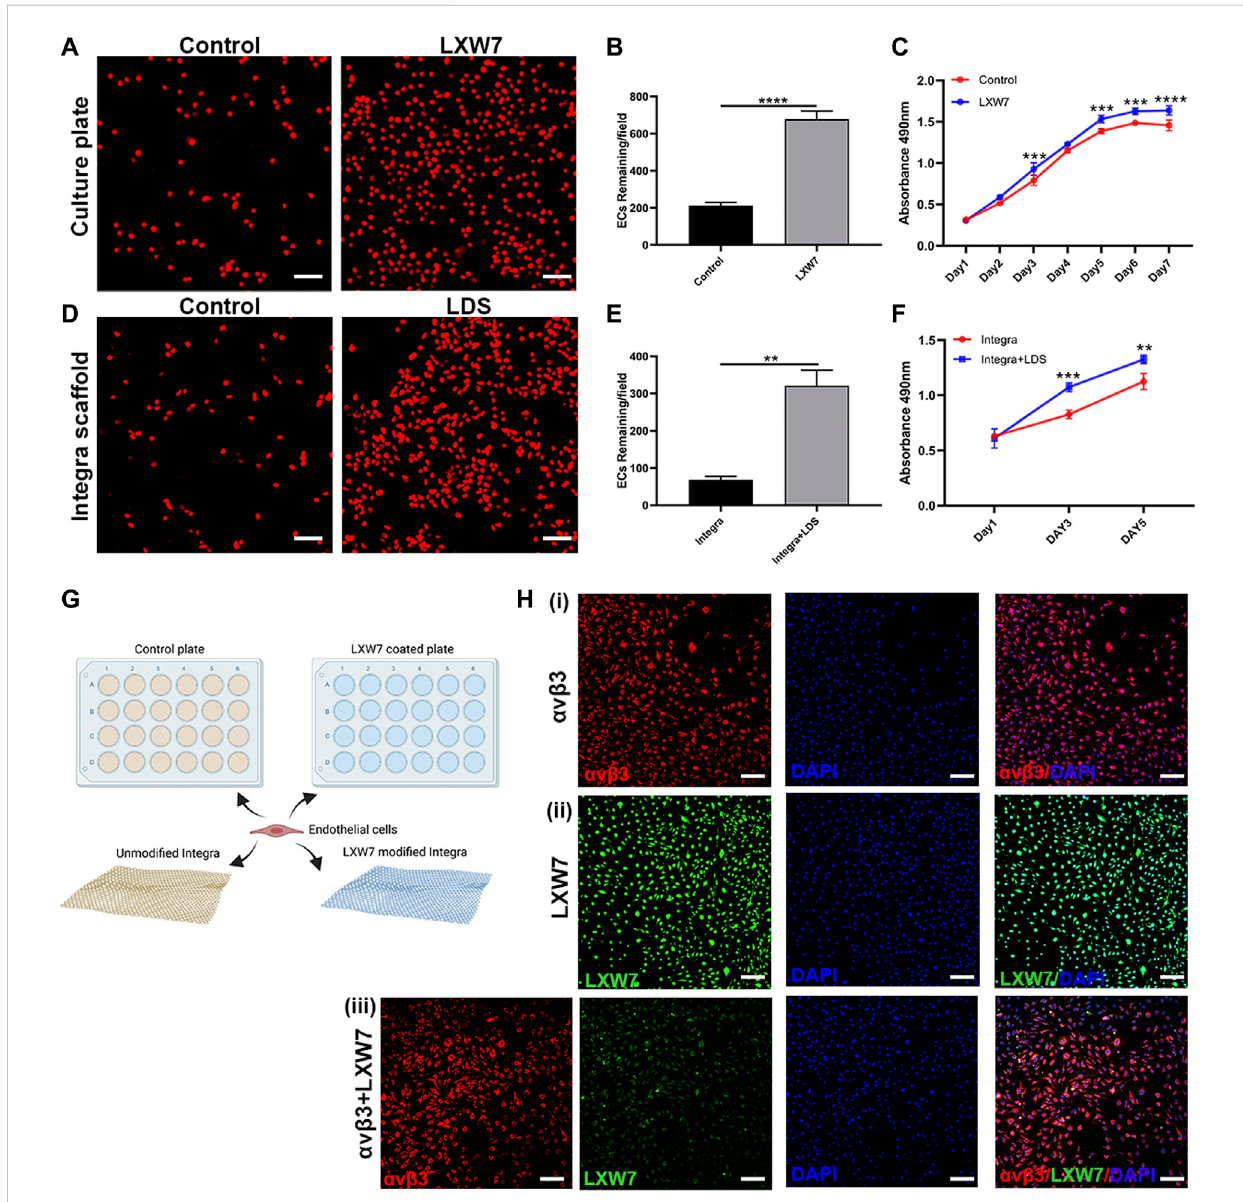
FIGURE 2 Effects of LXW7 and LDS on the attachment and proliferation of ECs. (A, D) Representative images of ECs attached on D-Biotin(control) or LXW7- Biotin treated culture plate and Integra (control) (A) or LDS treated Integra scaffold (D) after 30 min incubation. (B, E) Quantitative data and analysis of remaining cells on culture plate (B) and Integra scaffold (E) . (C, F) Proliferation and viability of ECs on D-Biotin (control) or LXW7-Biotin treated culture plate (C) andonIntegrascaffoldorLDStreatedIntegrascaffold (F) weremeasuredbyMTSassayatdifferenttimepoints. (G) SchemeofdesignofECs attachmentassayoncultureplateorIntegrascaffold. (H) Representativeimagesofintegrin α v β 3expressiononECs(i),LXW7bindingef fi ciencyonECs(ii), and integrin α v β 3+LXW7 co-staining (iii). Scale bar = 50 μ m. Data are expressed as mean ± SD. * p < 0.05, ** p < 0.01, *** p < 0.001, and **** p <